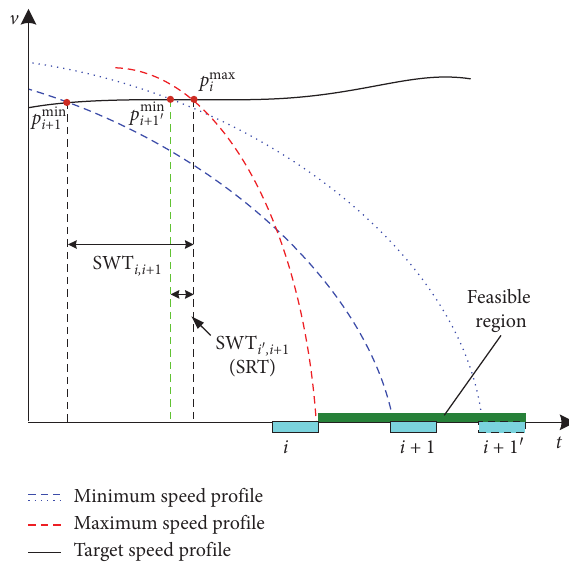
Figure 4: Characteristic of distance demand for ASAs.